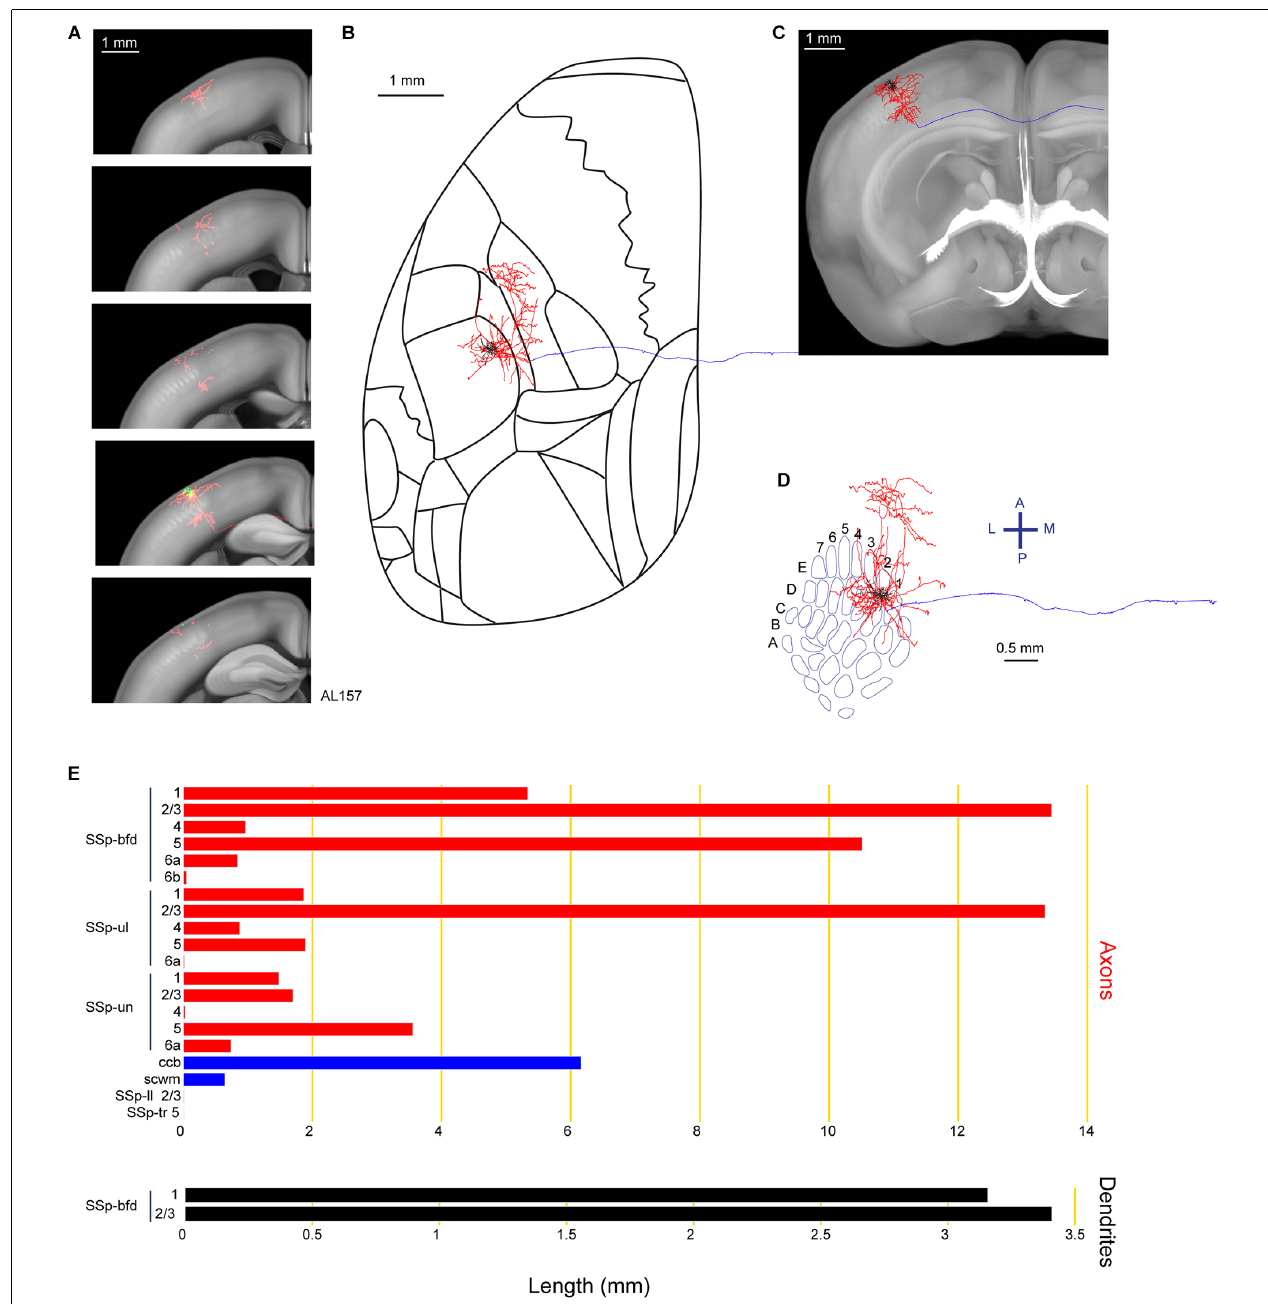
FIGURE 4 | Reconstruction and quantification of example neuron AL157 with projections to the primary somatosensory cortex upper limb area. (A) Serial overlays of axon (red) and dendrites (green) in coronal views encompassing the anterior-posterior span of the axons of 2.125 mm. Each section represents a maximum projection of 425 µ m. (B) Maximum projection of the reconstructed axon and dendrites in horizontal view. (C) Maximum projection of the axon and dendrites in coronal view. (D) Maximum projection of the axon and dendrites in tangential view (rotated 30 degrees) over the barrel field. The cell is located in the E2 barrel column. (E) Quantification of axonal (top) and dendritic (bottom) length in respective brain regions identified by the Allen Mouse CCFv3. For (B) to (E) : dendrites are shown in black; axon in neocortical gray matter is shown in red; axon in white matter is shown in